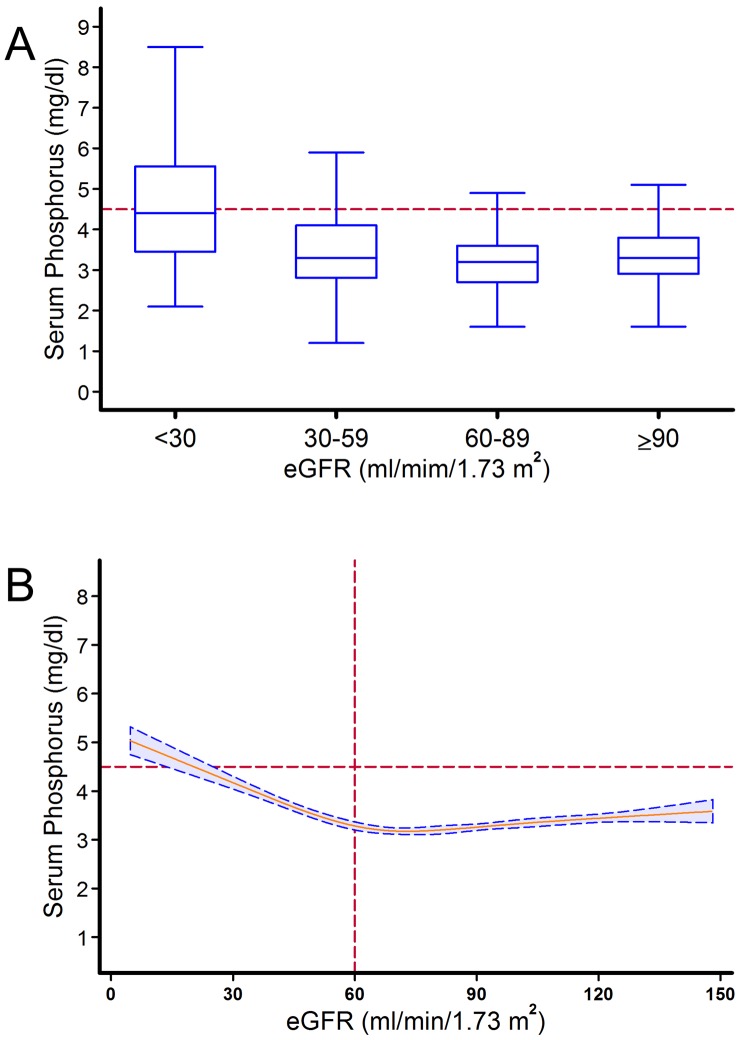
Relationship between serum phosphorus and renal function. A.Box–and–whisker plots of changes in serum phosphorus level according to the severity of renal dysfunction. The line within the box denotes the median and the box spans the interquartile range (25th to 75th percentiles). Whiskers extend from the 5th to 95th percentiles. B. Spline function graph of the relationship between estimated glomerular filtration rate and serum phosphorus, showing the shape of the relationship curve on a continuous basis. The blue area with dotted lines indicate the 95% confidence interval.